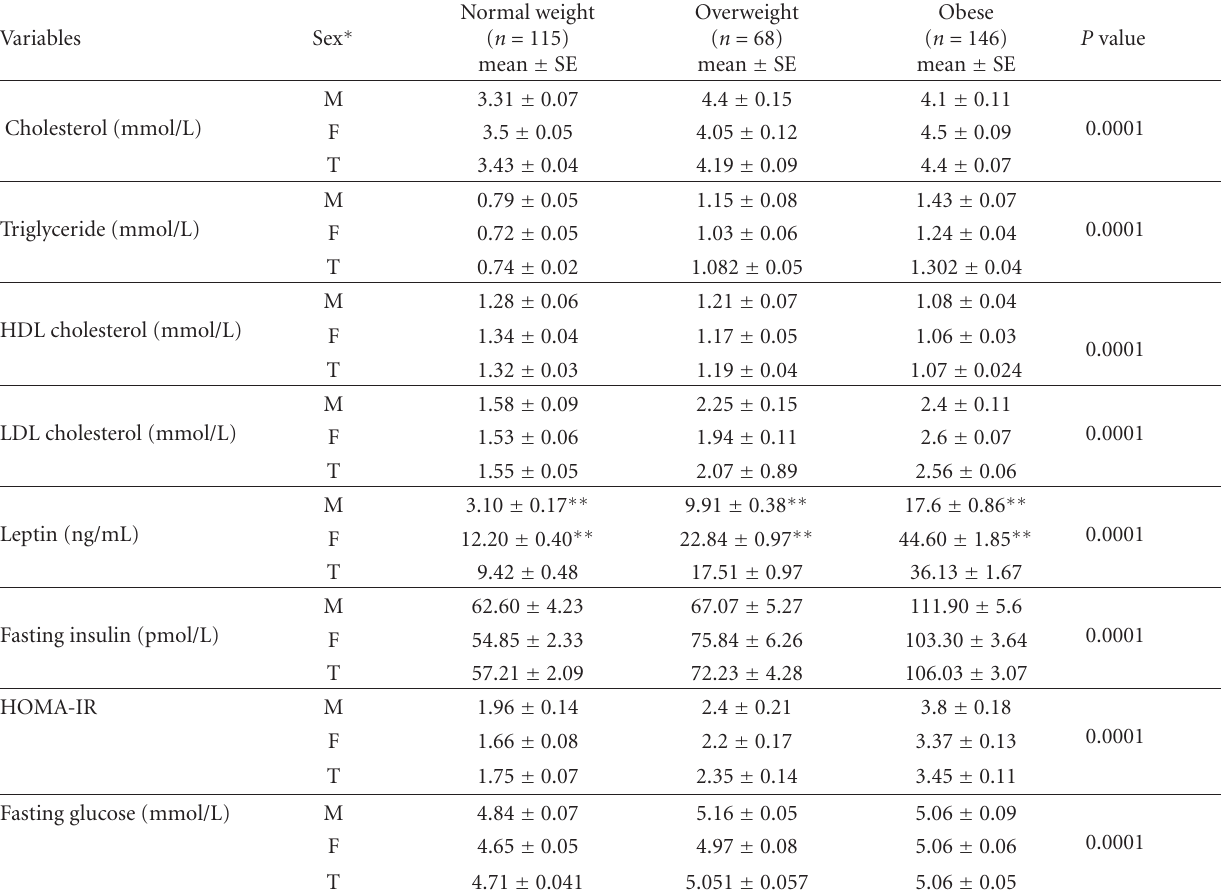
Table 2: Comparisons of clinical parameters amongst normal-weight, overweight, and obese males and females (from [28]). Variables Sex